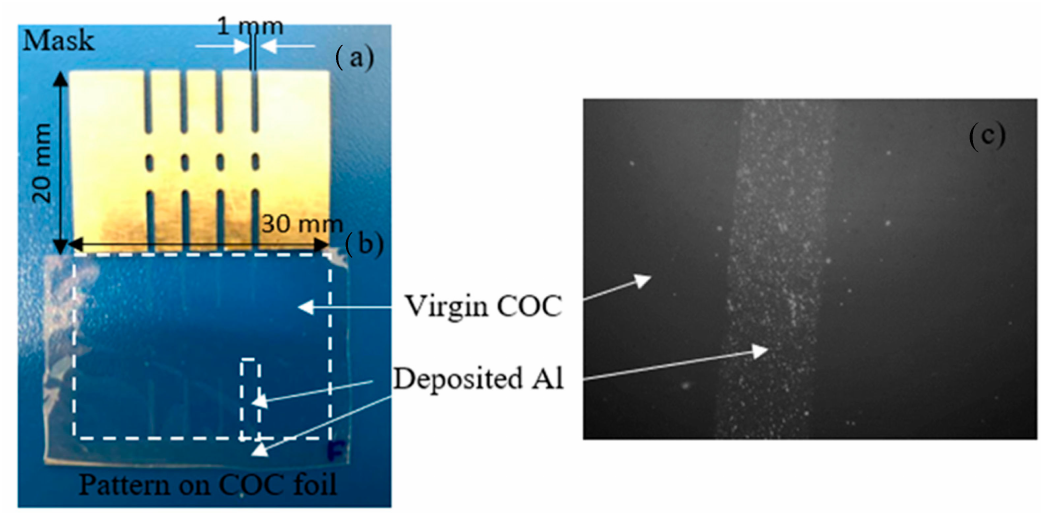
Figure 3. Picture of the mask ( a ) used to realize a pattern on COC foil ( b ) and optical image 4 × magnified of a detail of the pattern reproduced on COC ( c ).